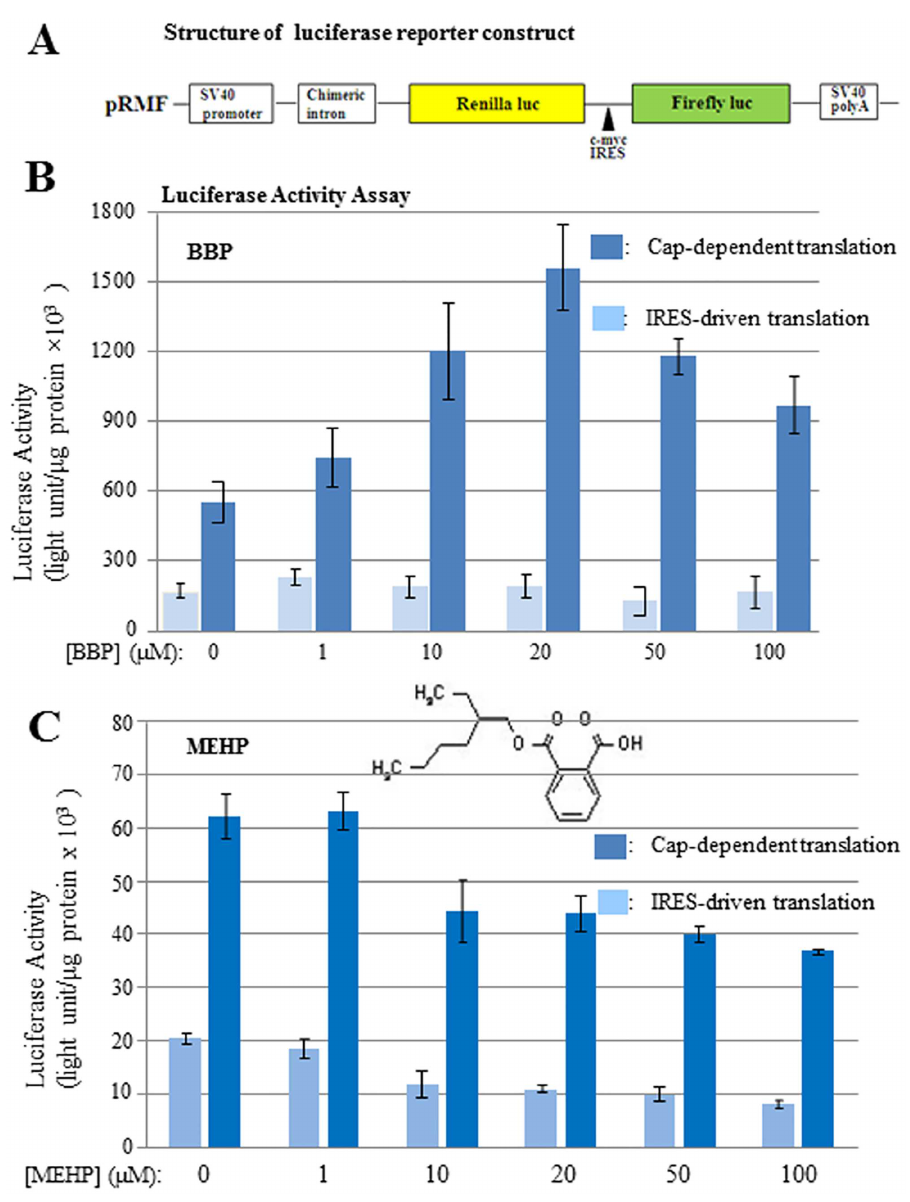
Fig 2. The effects of BBP and MEHP on mRNA translation in HEK-293T cells. HEK-293T cells were grown to 80% confluenceand transfected with luciferasereporter. Eight hours later, cells were treated with BBP or MEHP for 24 hrs at the concentrations indicated.Equal volume of vehicle(methanol) was used as the control. Cells were harvestedby washingonce with cold PBS, and the cell lysate was preparedwith PBL buffer (Promega) for the luciferase activity measurement using dualluciferase assay kit (Promega). (A) Schematicdiagram of the reporter construct used in this experiment and throughoutthe whole study. (B) The effect of BBP on cap-dependent and IRES-driven translation; luciferase activity is the readout of translational activity. (C) The effect of MEHP on cap-dependent and IRES-driven translation. The structure of MEHP was insertedin the chart. The experiments were repeated three times, and the means were shown with standard